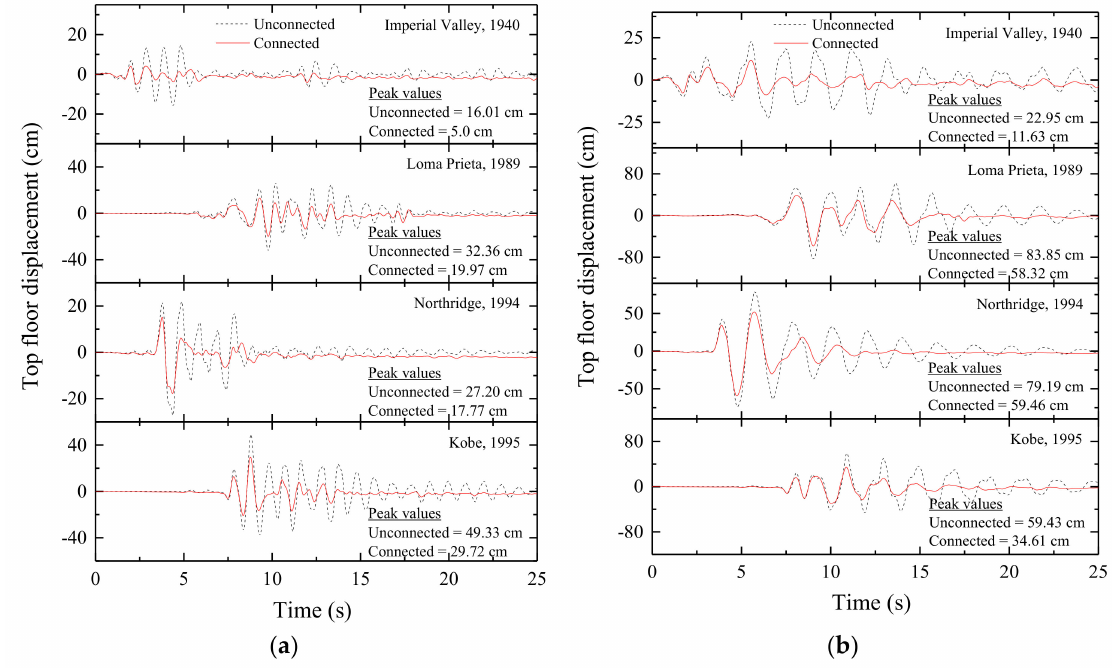
Figure 8. Time history of top floor displacement in: ( a ) a coupled stiff building and ( b ) a coupled flexible building when semi-active MR dampers are used as coupling devices in Configuration 1.